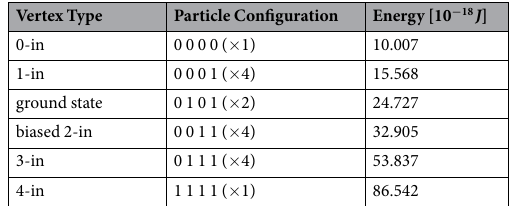
Table 1. Magnetostatic energy for each vertex type at B = 16 mT. An example configuration for each vertex is listed. “1” (“0”) indicates a colloid close to (far from) the vertex and ( × n ) indicates that n different equivalent configurations can be obtained by rotation.